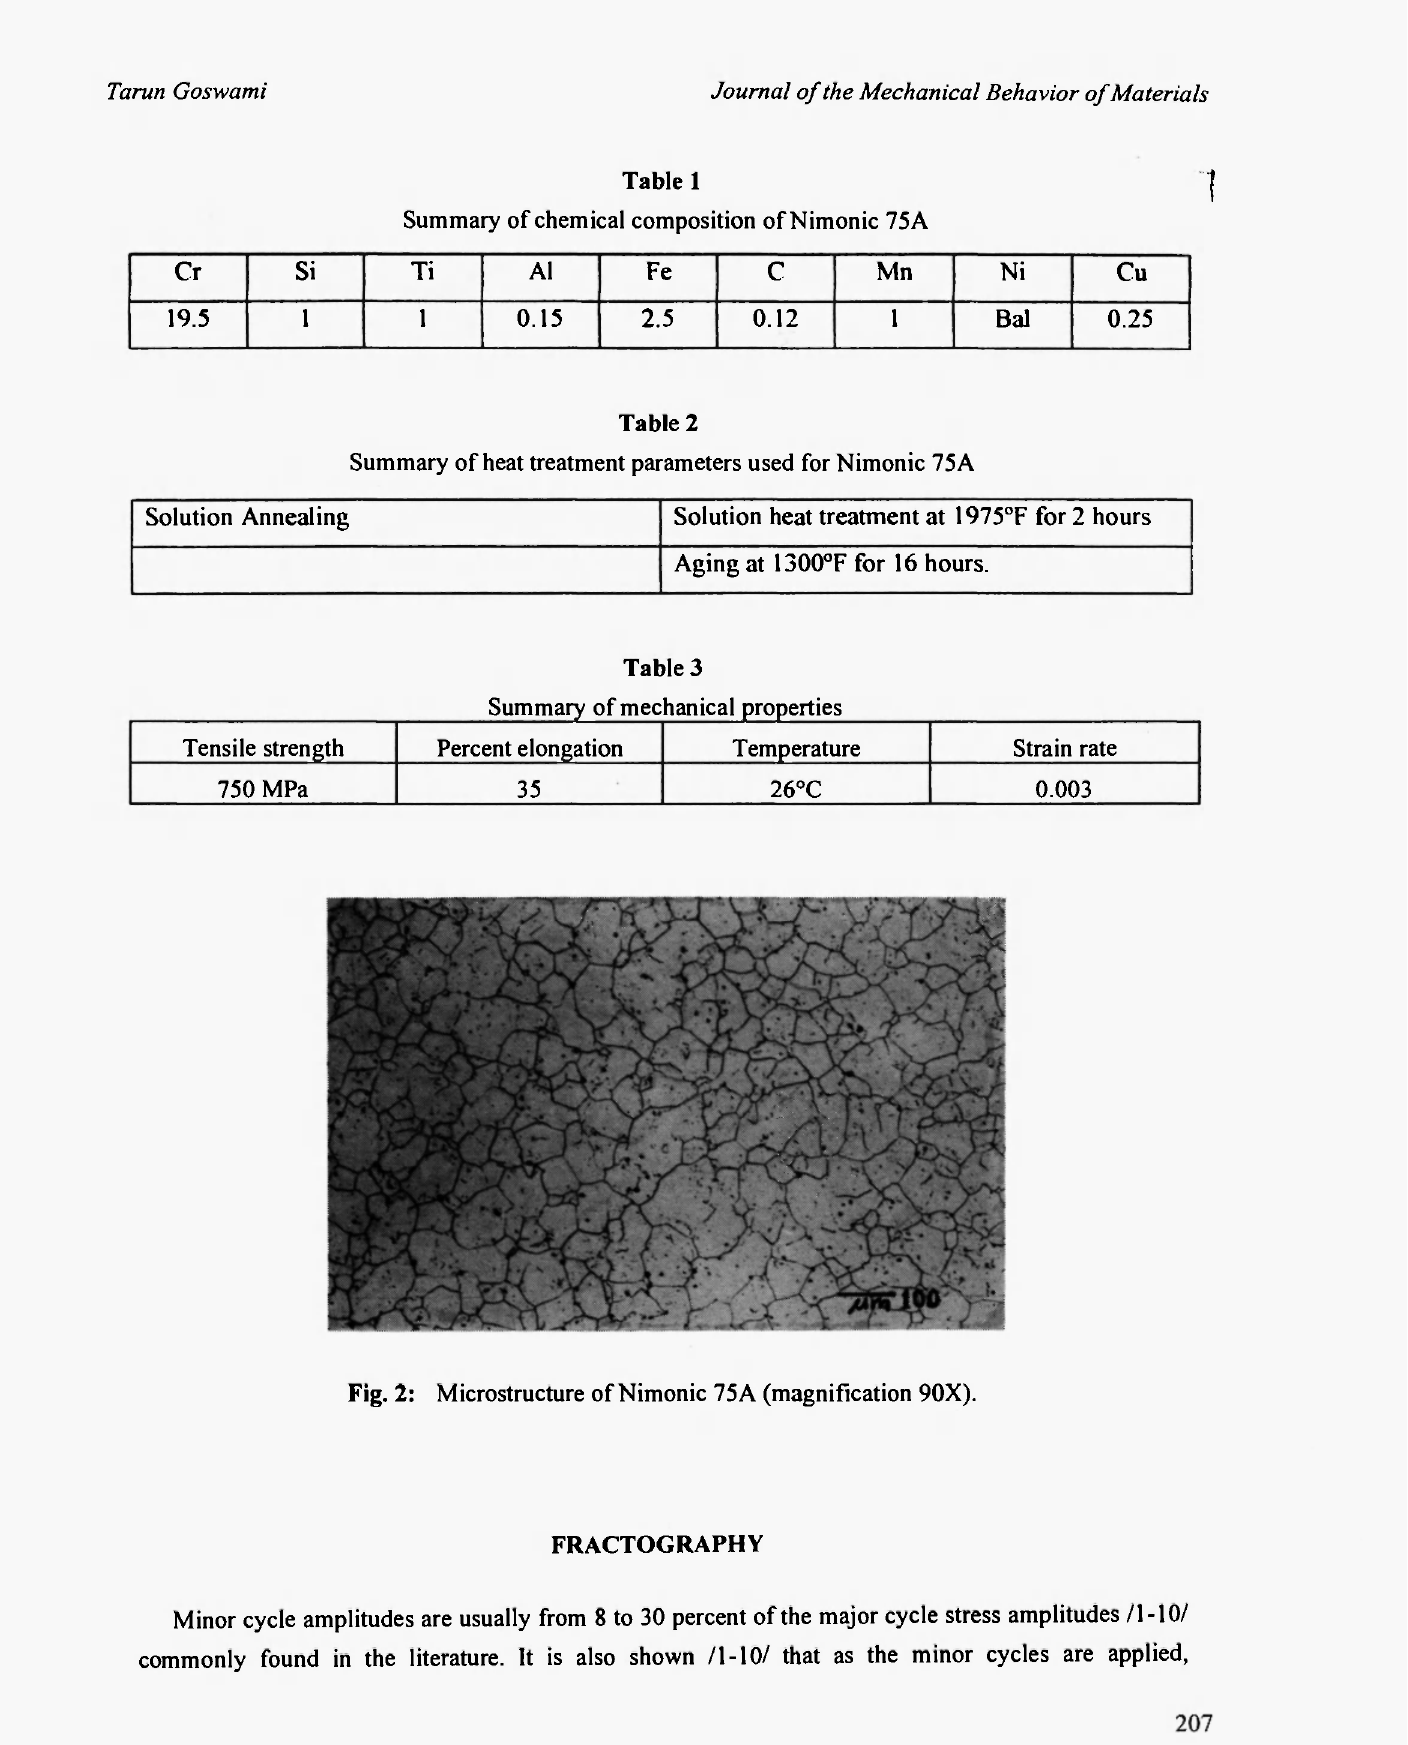
Fig. 2: Microstructure of Nimonic 75 A (magnification